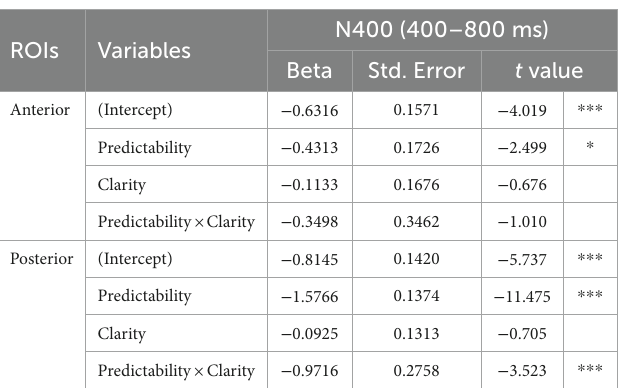
TABLE 2 LMM estimates of fixed effects for the predictability and clarity effects on the N400.